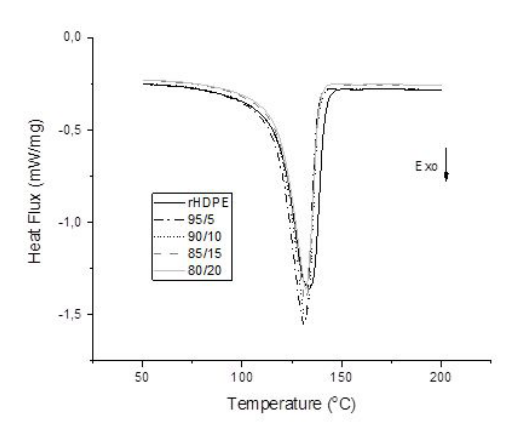
Figure 6. DSC curves (data used are from the second heating) of rHDPE/mica formulations